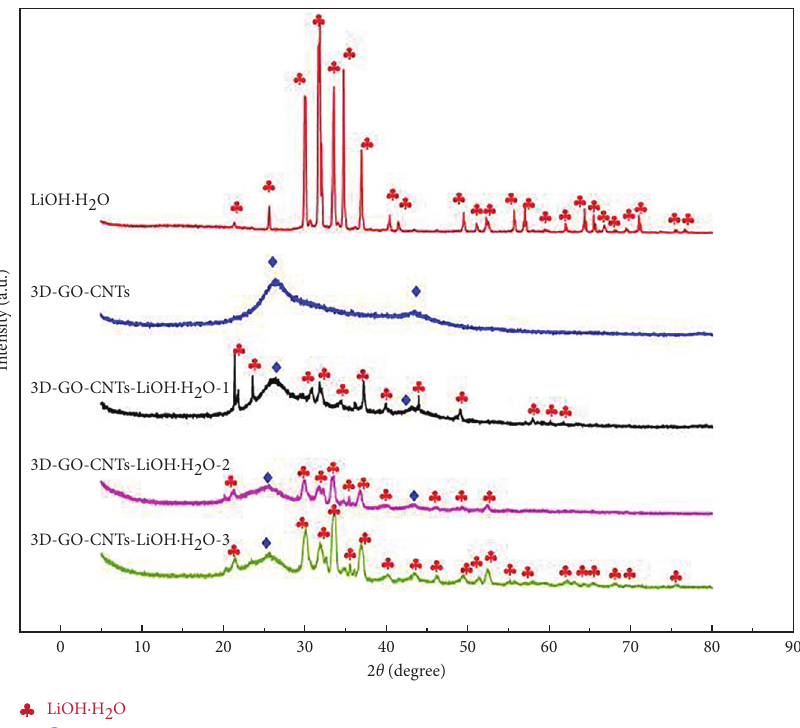
Figure 3: XRD spectra of LiOH · H